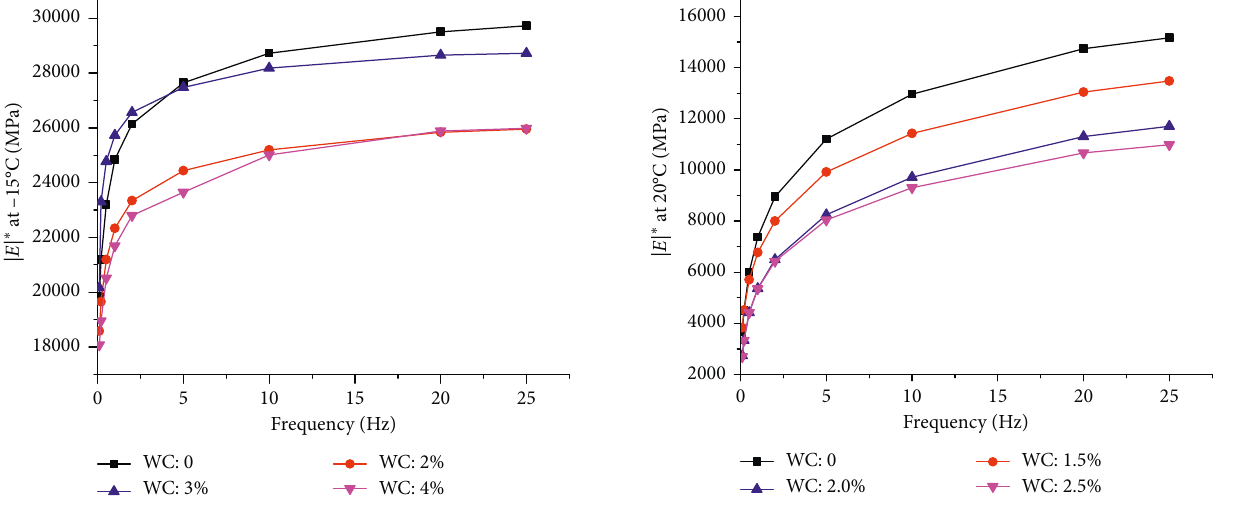
Figure 7: SBS#AC-20-type low-temperature dynamic modulus.